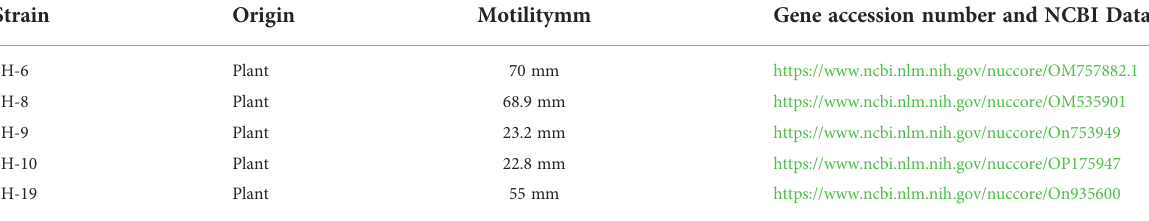
TABLE 1 Bacterial strain, motility and NCBI gene accession link.